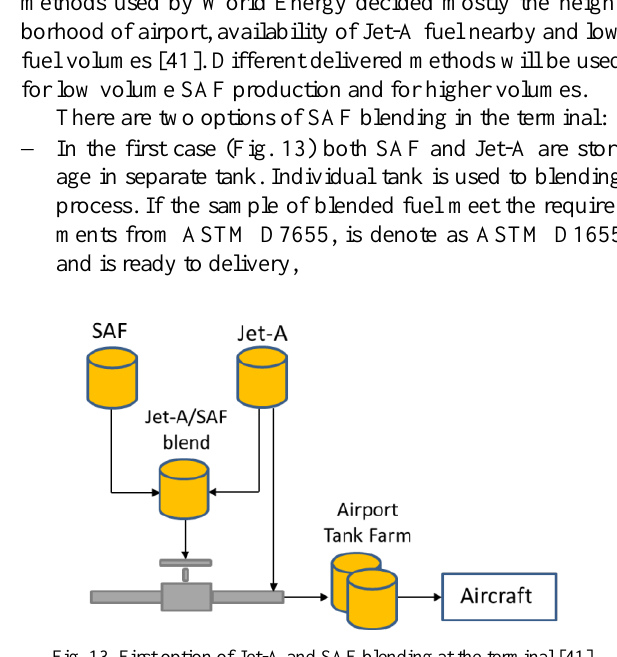
Fig. 13. First option of Jet-A and SAF blending at the terminal